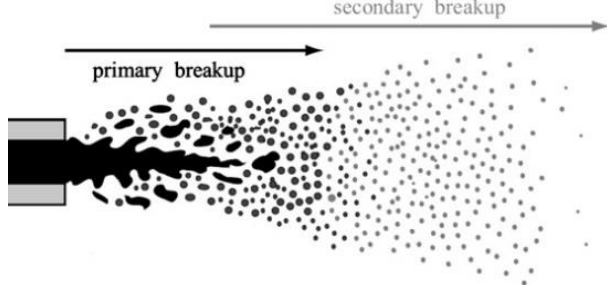
Figure 2. Primary and secondary breakup processes.